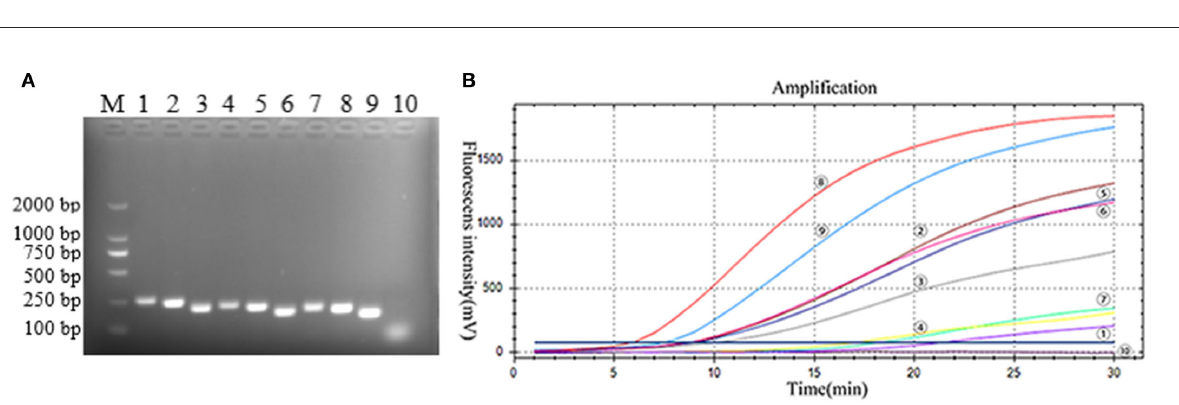
FIGURE2 (A) Best primer screen. M: DL2000 marker; 1–9: 9 pairs of PoRVA primers, 1: R-F1-R1, 2: R-F1-R2, 3: R-F1-R3, 4: R-F2-R1, 5: R-F2-R2, 6: R-F2-R3, 7: R-F3-R1, 8: R-F3-R2, 9: R-F3-R3; 10: Negative Control. (B) RT-RAA primer screening results. ‹ :R-F1-R1, › : R-F1-R2, fi : R-F1-R3, fl : R-F2-R1, (cid:176) : R-F2-R2, – : R-F2-R3, † : R-F3-R1, ‡ : R-F3-R2, · : R-F3-R3; (cid:181) : negative control. TT value: ‡ : 6.16, · : 7.84, › : 9.19, (cid:176) : 9.34, – : 9.27, fi : 10.80, † :17.72, fl : 18.96, ‹ : 20.20, (cid:181) : none.